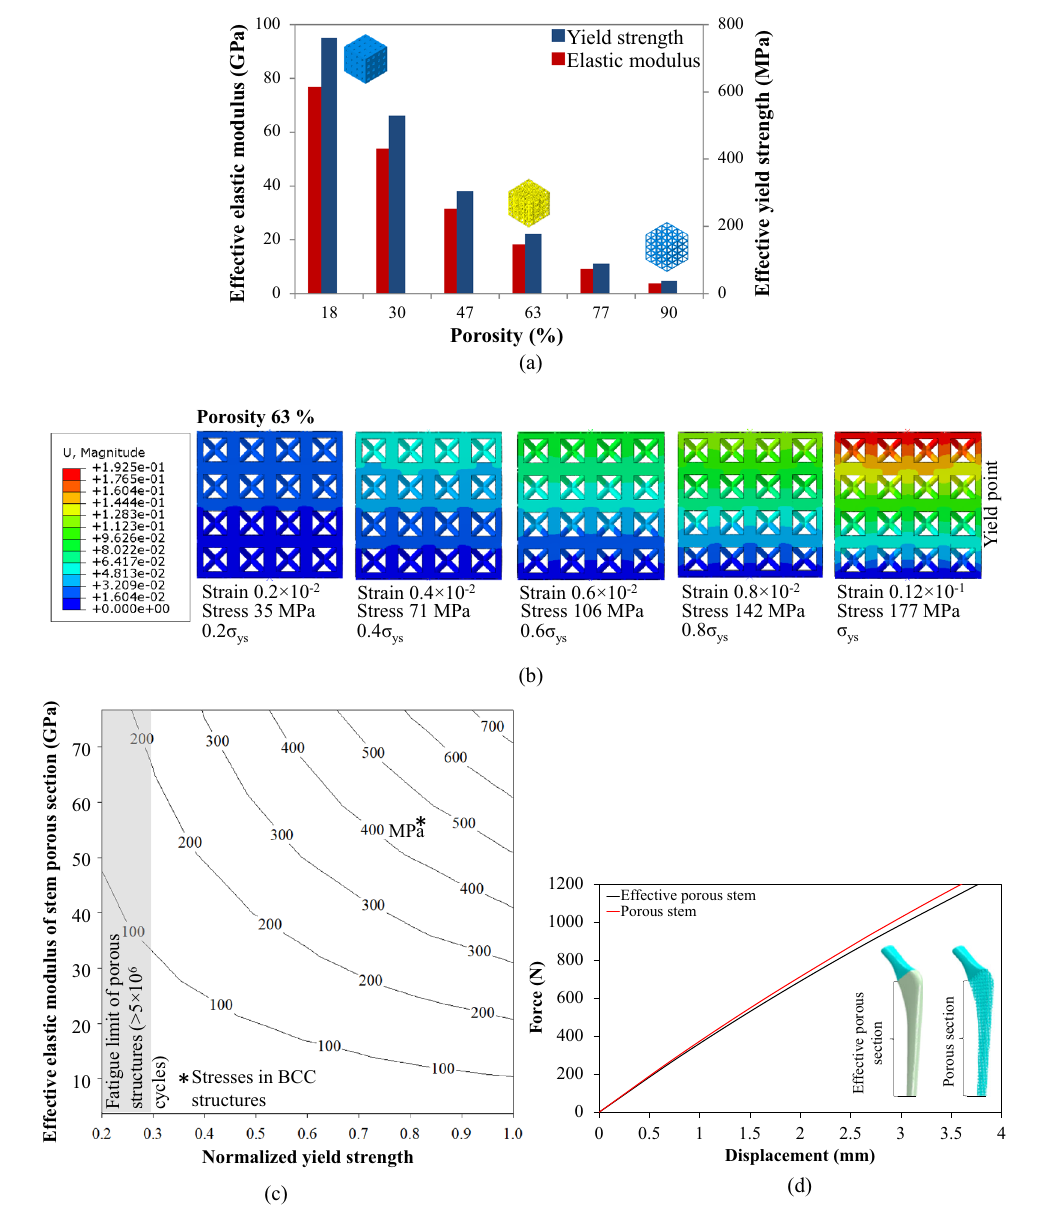
Fig. 3 Results of fi nite element models; a effective mechanical properties versus porosity, b different stresses and strains at different displacements, d validation results of solid and porous c calculation of 0.3 σ ys as endurance limit and